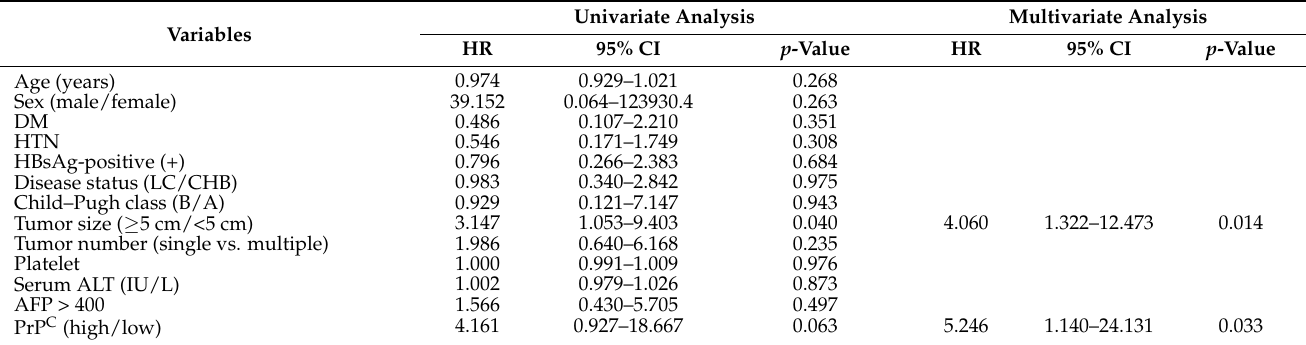
Table 2. Univariate and multivariate cox analysis for mortality following surgical